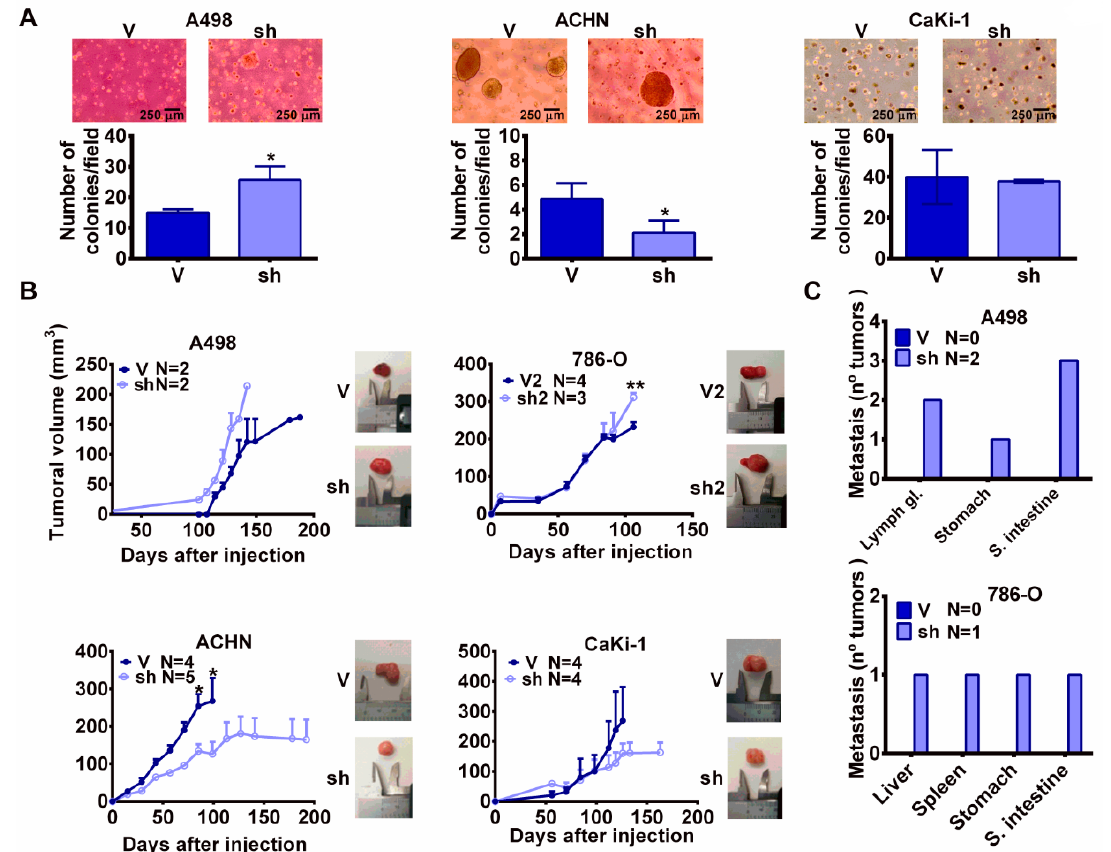
Figure 5. MYBBP1A knock down increases tumorigenicity in c-MYB + cell lines. ( A ) Cells expressing the scramble vector (V) or MYBBP1A shRNA (sh) were seeded in soft agar. After 3-6 weeks, colonies were counted. Scale bars: 100 µm. ( B ) MYBBP1A knock down increases xenograft size of c-MYB + pVHL − cell lines. A498, 786-O, ACHN and Caki-1 control cells (V/V2) or MYBBP1A knock down cells (sh/sh2) were injected in nude mice and tumor size was measured weekly. Graphs represent the tumor size (mean ± SEM). Representative images of tumor size are shown. ( C ) Number of metastasis instances observed in organs of nude mice after injection of A498 and 786-O cells expressing the scramble vector (V) or MYBBP1A shRNA (sh). * p < 0.05; ** p < 0.0.